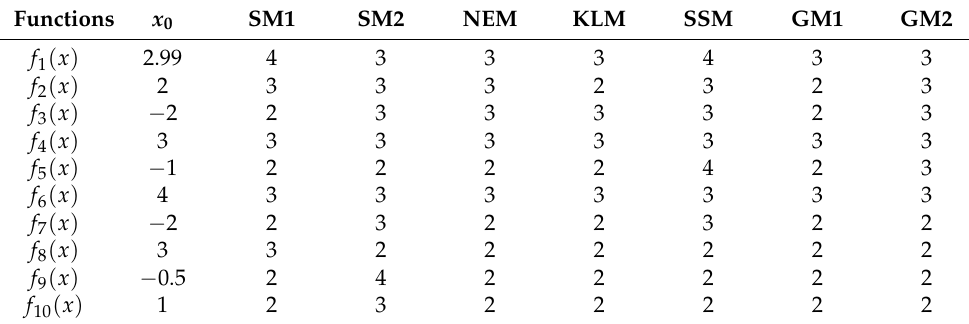
Table 2. Comparison of the number of iterations.